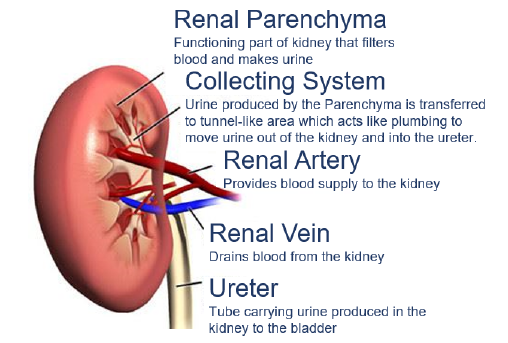
Figure 1. Kidney parenchyma.